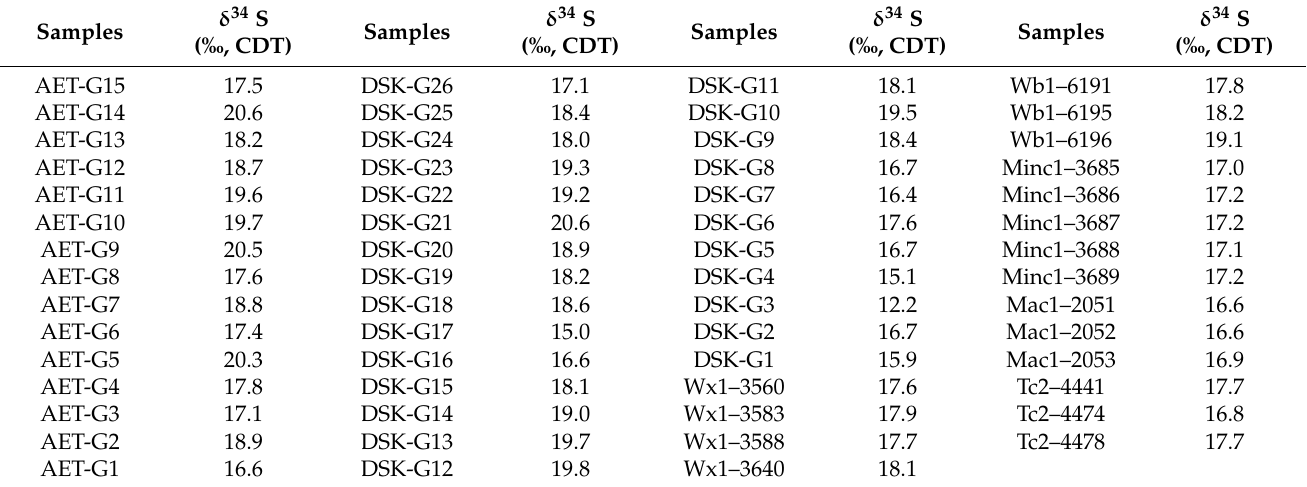
Table 1. Sulfur isotopic composition of seawater gypsum in the Paleocene